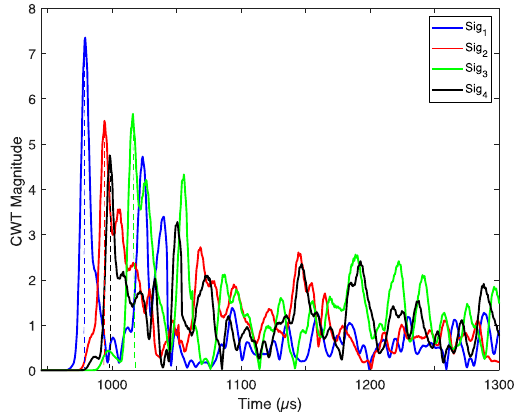
Figure 5. Line profile of the AE scalograms where the time of arrival is determined at the maximum magnitude of the wavelet transforms of the detected AE hits (i.e., PLB1) considered at the average frequency 𝑓̅ = 282.63 kHz .